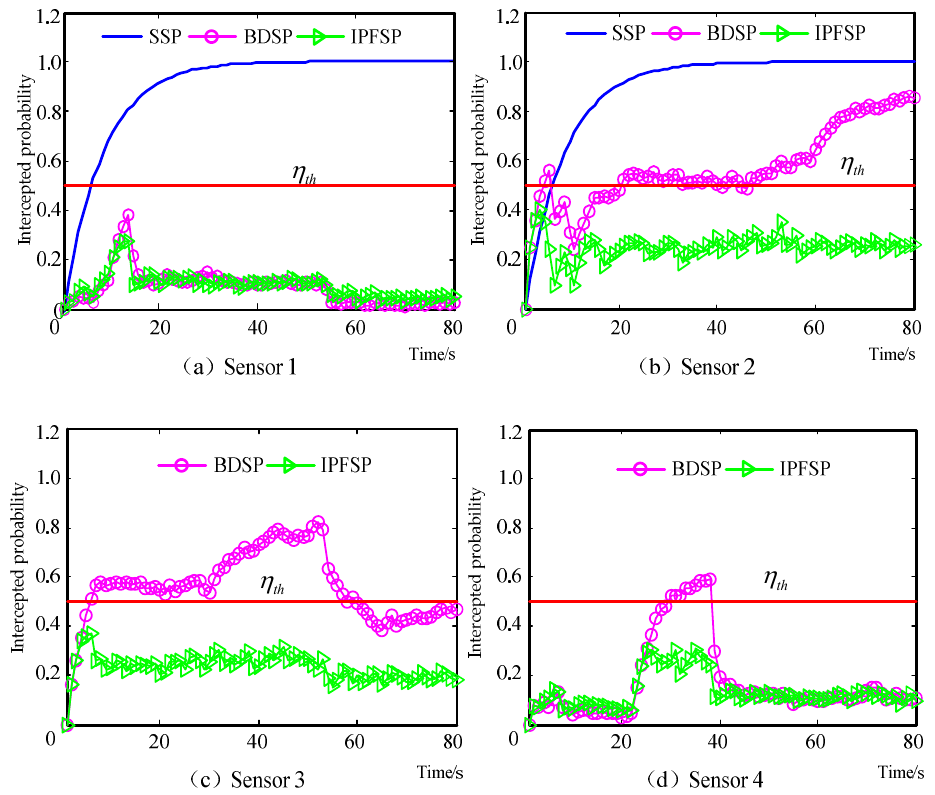
Figure 22. Sensor intercept probability under different scheduling policies. ( a ) Sensor 1; ( b ) Sensor 2; ( c ) Sensor 3; ( d ) Sensor 4.